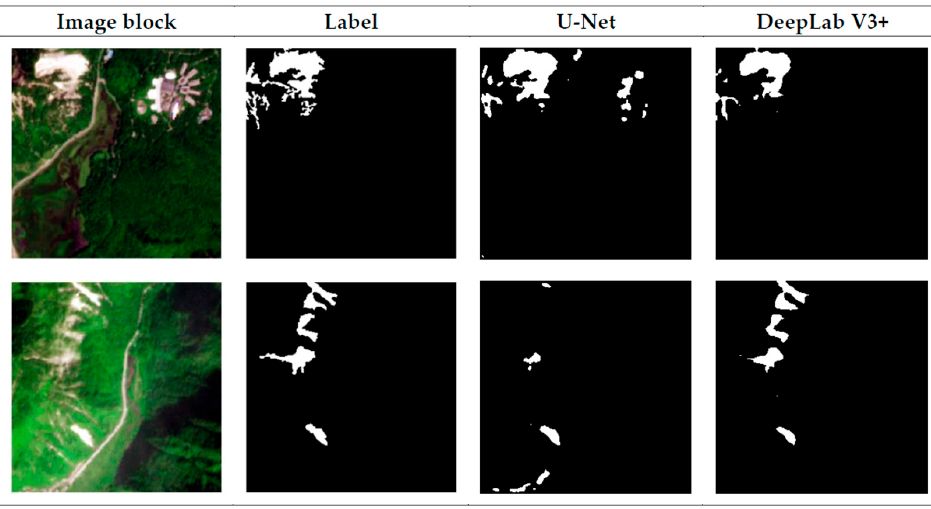
Figure 14. Comparison of coseismic landslide prediction time in different experiments.